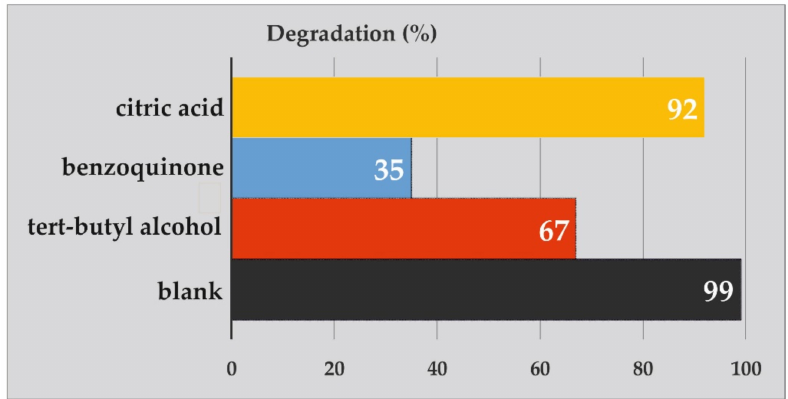
Figure 8. The e ff ect of di ff erent scavengers (benzoquinone, tert-butyl alcohol and citric acid) on the photocatalytic degradation of